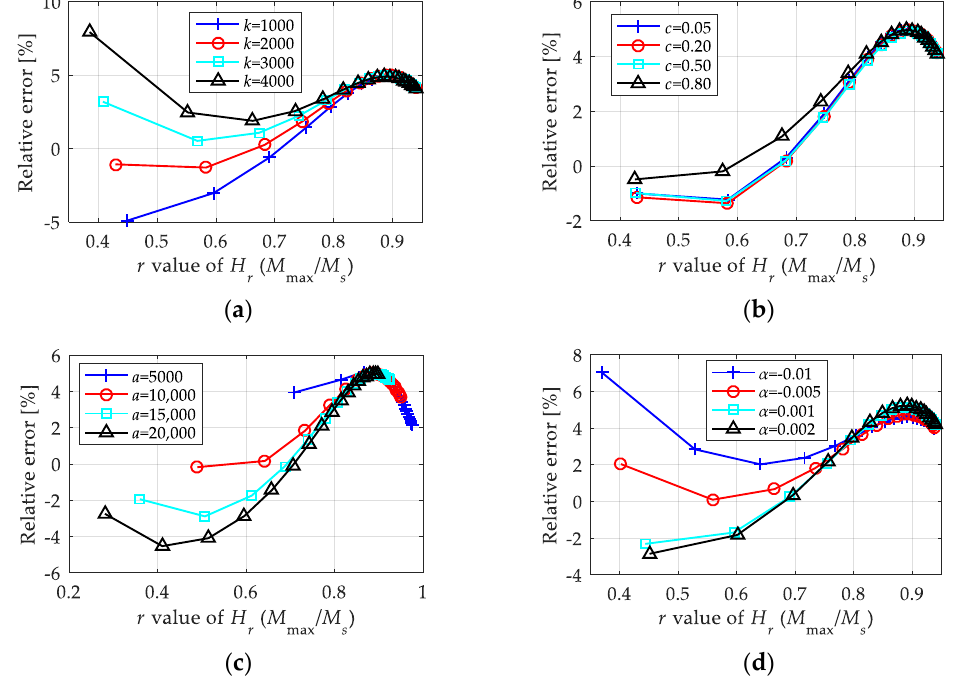
Figure 15. Relative errors of the nonlinear model in calculating the magnetization amplitude and equivalent phase lag under univariate change condition: ( a ) k ∈ [1000 kA/m,4000 kA/m], a = 12 kA/m, c = 0.2, α = − 0.001; ( b ) a ∈ [5000 kA/m, 20,000 kA/m], k = 2 kA/m, c = 0.2, α = − 0.001; ( c ) α ∈ [ − 0.01,0.002], k = 2 kA/m, a = 12 kA/m, c = 0.2; ( d ) c ∈ [0.05,0.8], k = 2 kA/m, a = 12 kA/m, α = − 0.001.